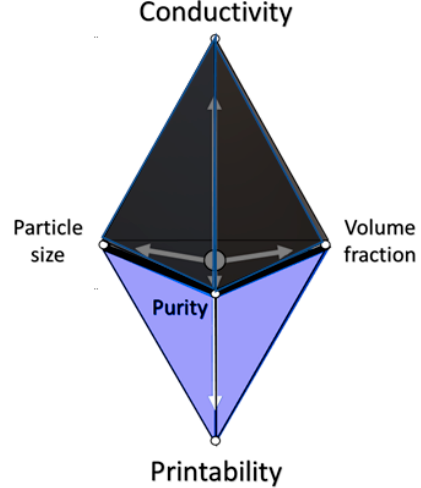
Figure 2. Graphical representation of the general relationship of the conductivity trade-off with printability, in terms of tailoring conductive inks. The variables in the base triangle increase (particle size ( µ m), volume fraction (%), and purity (%)) the conductivity increases. Conversely, the printability increases with decreases in these